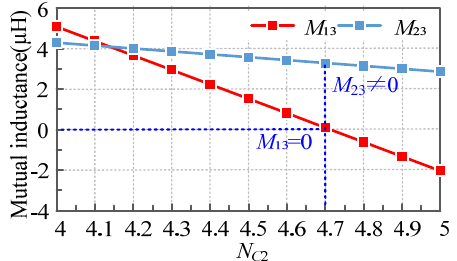
Figure 8. Simulated M 13 and M 23 versus N C2 ( ∆ X = ∆ Y = 0 and ∆ Z = 13 cm).